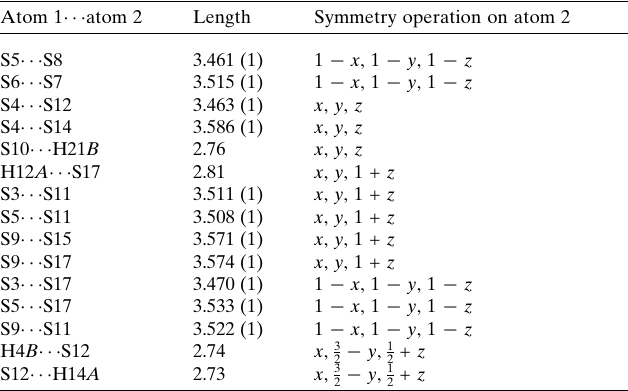
Table 1 Table of contacts (A˚ ) shorter than the sum of the van der Waals radii.